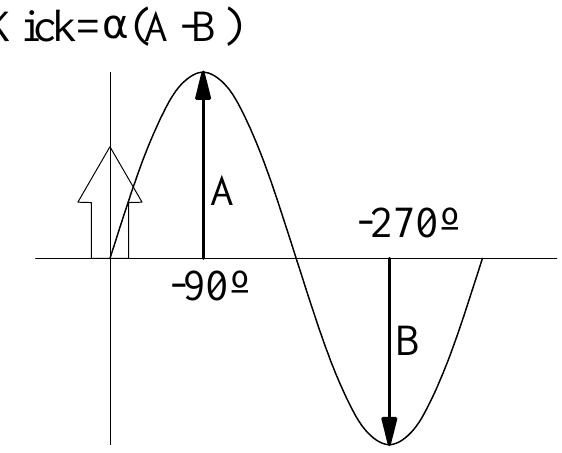
FIG. 1. Tap positions for the two-tap FIR